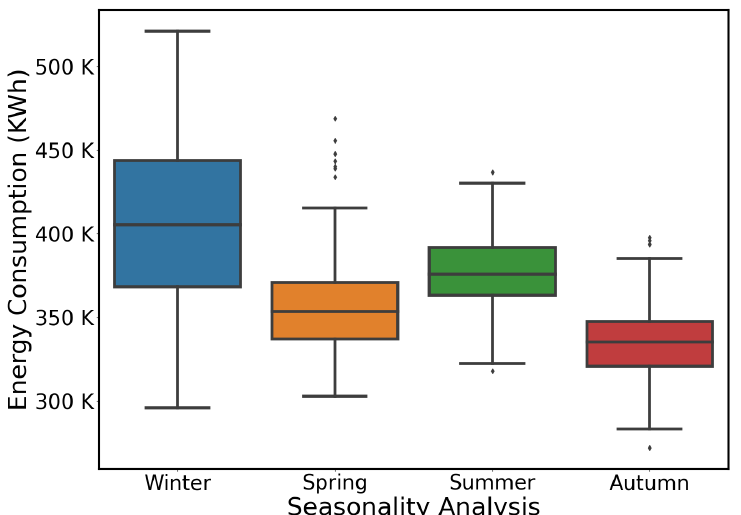
Figure 6. Seasonality Analysis of electric Consumption data. Time series electric consumption data is sequential, and current consumption pat- terns correlate with past consumption and possess temporal dependencies. Not a